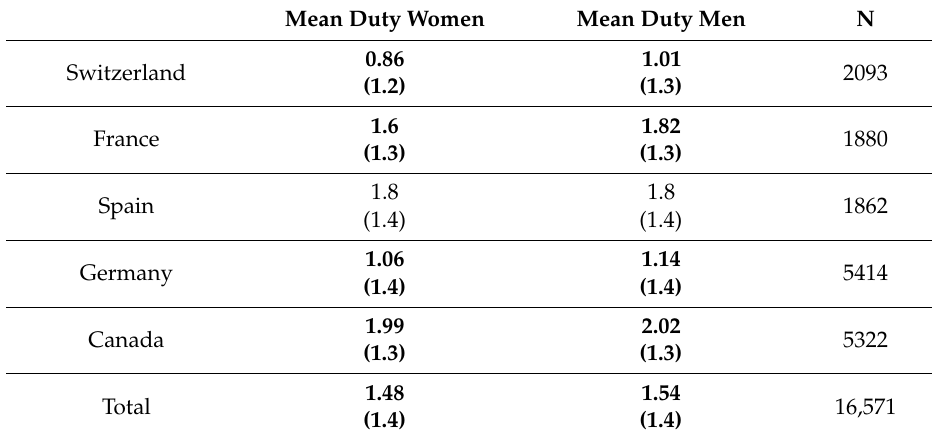
Table 4. MEDW (2011–2015). Duty at the national level. Averages by gender and